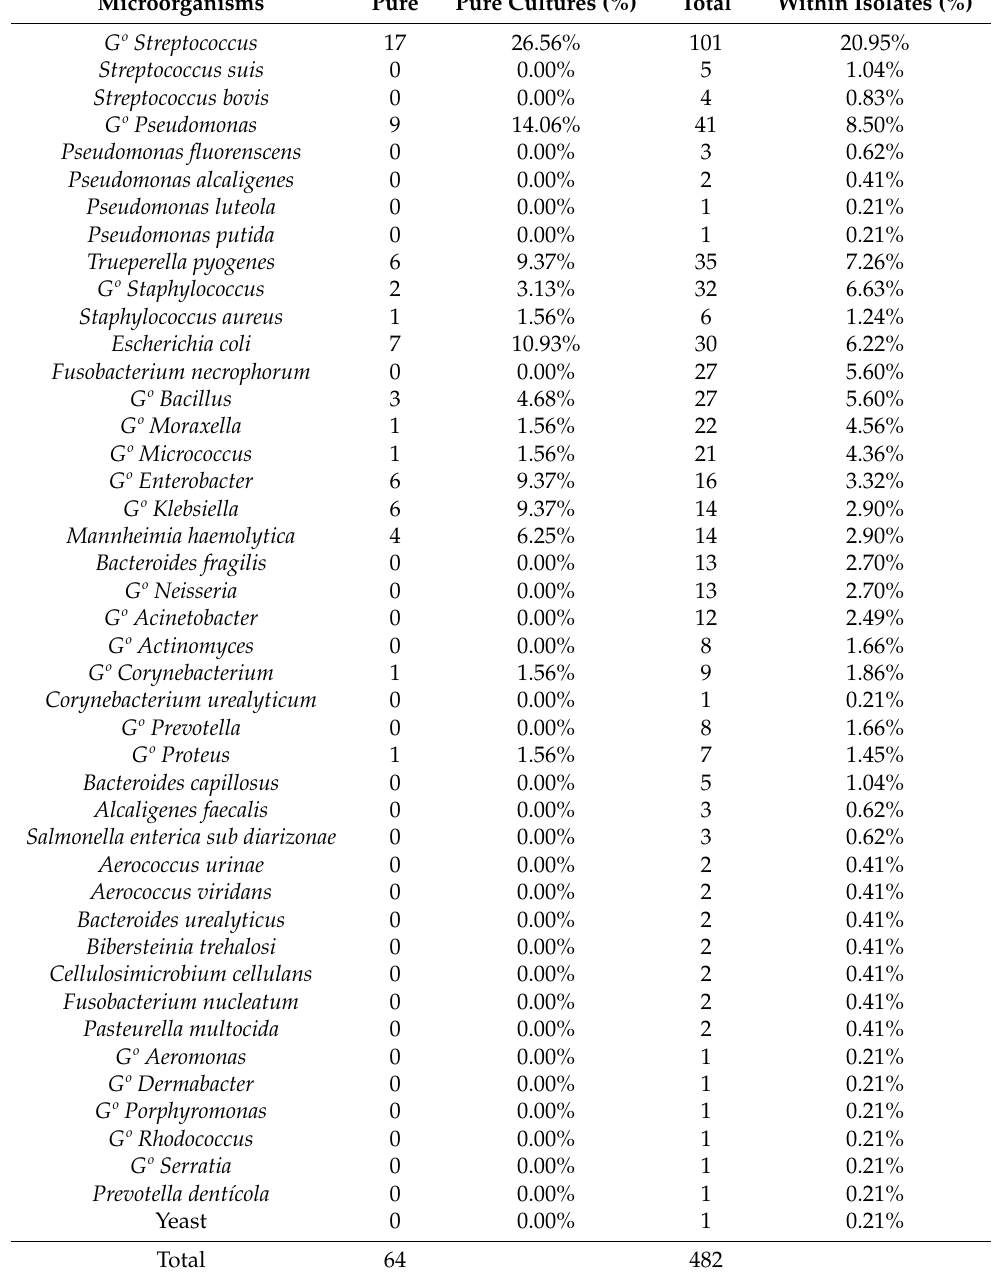
Table 1. Isolated microorganisms ordered by their relevance within the number of isolates (482) and the percentage of pure